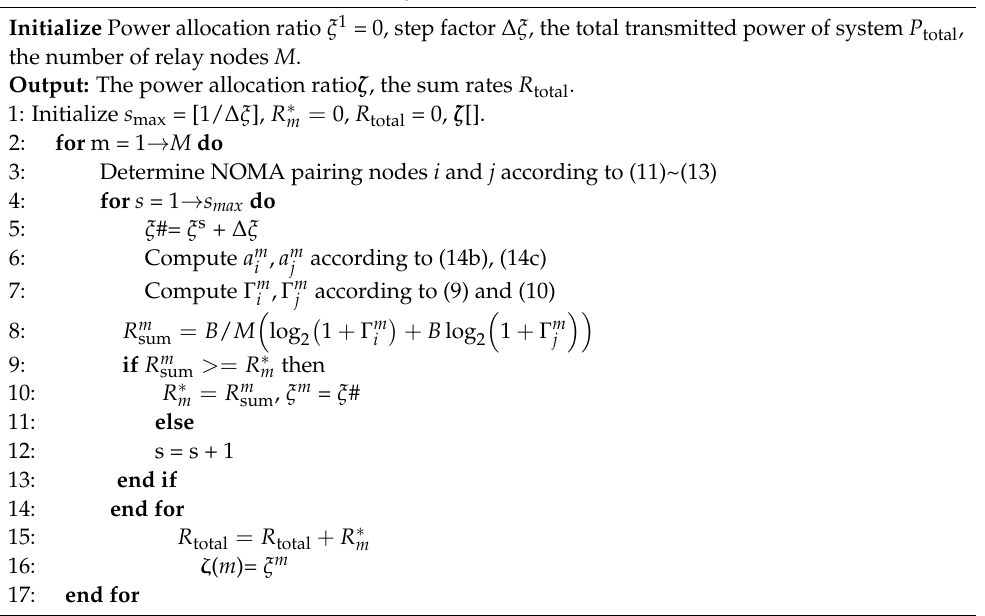
Algorithm 1 Fixed Power Allocation